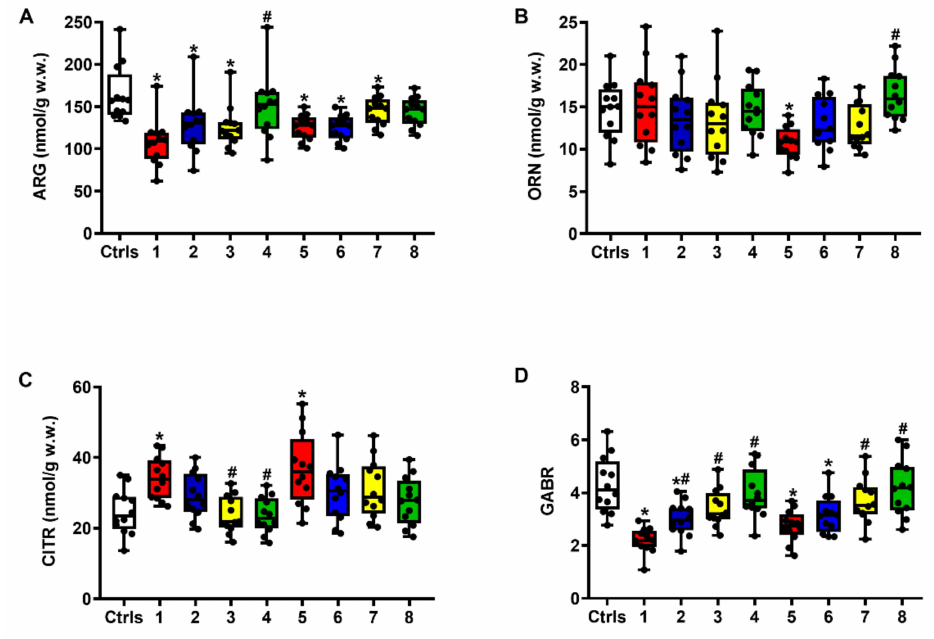
Figure 3. The box plots reporting all data points ( • ), minimum, maximum, median, 25 and 75 percentiles of Arg ( A ) and its metabolites Orn ( B ) and Citr ( C ), together with the global arginine bioavailability ratio (GABR = Arg/Orn + Citr) ( D ), in rats without and with the s.c. administration of increasing ILB ® doses (1, 5 and 15 mg/kg b.w.). Ctrls = control sham-operated rats; 1 = sTBI only, sacrificed at 2 days post-injury; 2 = sTBI + 1 mg/kg b.w. ILB ® , sacrificed at 2 days post-injury; 3 = sTBI + 5 mg/kg b.w. ILB ® , sacrificed at 2 days post-injury; 4 = sTBI + 15 mg/kg b.w. ILB ® , sacrificed at 2 days post-injury; 5 = sTBI only, sacrificed at 7 days post-injury; 6 = sTBI + 1 mg/kg b.w. ILB ® , sacrificed at 7 days post-injury; 7 = sTBI + 5 mg/kg b.w. ILB ® , sacrificed at 7 days post-injury; 8 = sTBI + 15 mg/kg b.w. ILB ® , sacrificed at 7 days post-injury. * Significantly different from controls, q < 0.05. # Significantly different from corresponding time of untreated sTBI rats, q <